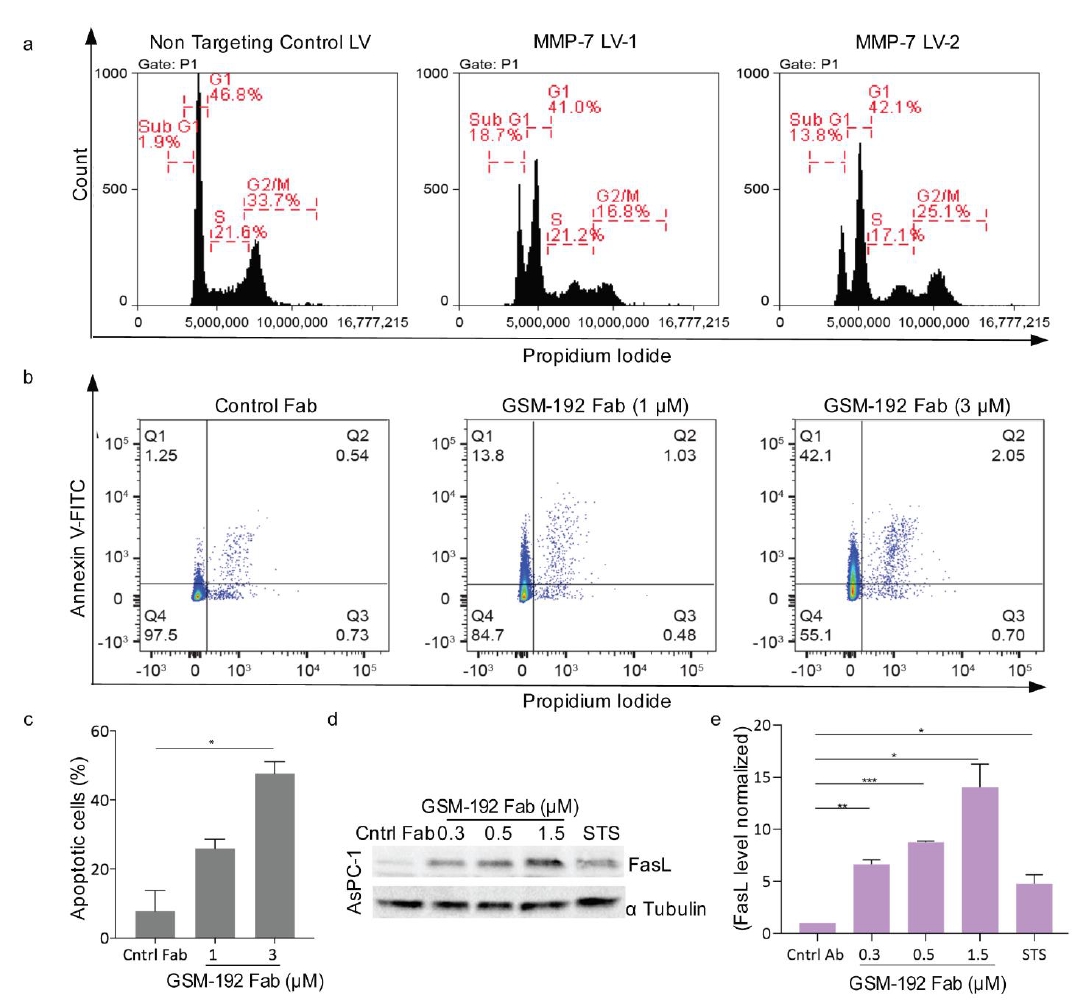
Figure 3. MMP-7 inhibition leads to cancer cell death in vitro. ( a ) MMP-7 lentiviral silencing resulted in increased subG1 peak indicating a leap in AsPC-1 cell death, in a FACS based cell cycle analysis. Cells exposed to MMP-7 targeting lentiviral vector (LV) showed an increase in sub G1 peak. See also Figure S4b. ( b ) MMP-7 inhibition leads to tumor cell death via apoptosis in AsPC-1 cells. FACS analysis showed increased Annexin V-related apoptosis (Q1+Q2) after treatment with increasing doses of GSM-192 Fab. FACS data output indicates early apoptotic cells as Q1, and late apoptotic cells as Q2. ( c ) Increase in percentage of cells undergoing apoptosis was plotted using mean values ± s.e.m (grey bar plot), and